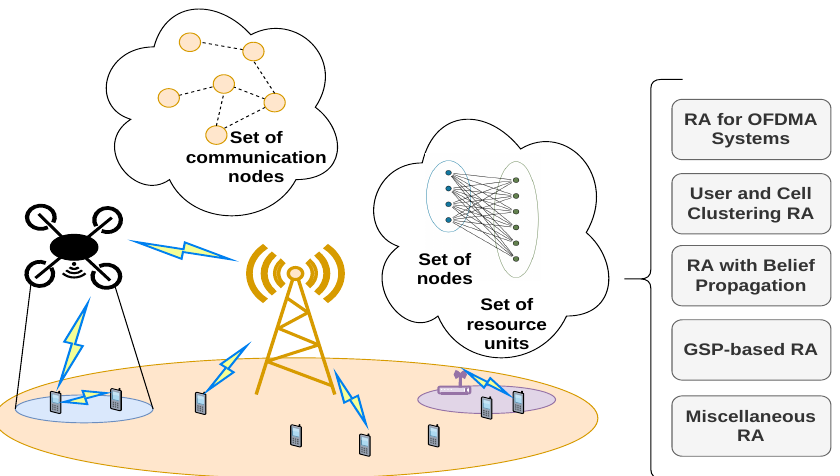
Figure 4. Scenario of homogeneous and Het-Nets and summary of methods for graph-based RA. Table 6. Tabular summary for graph-based RA in cellular homogeneous and